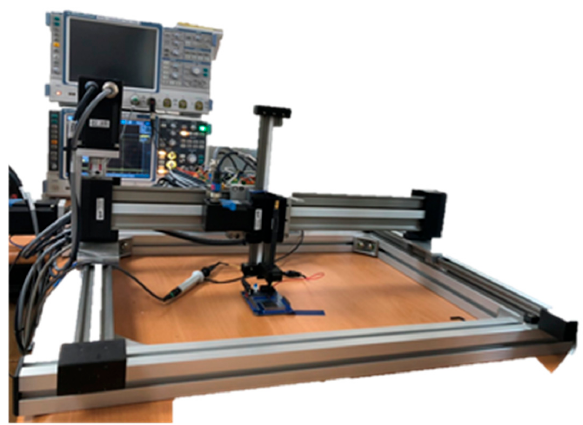
Figure 8. The platform of Figure 7.